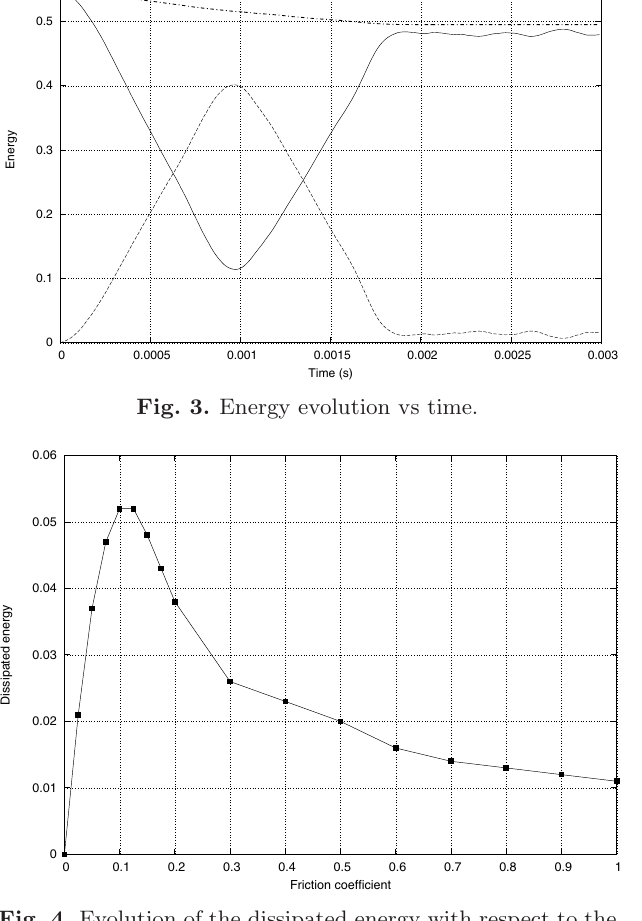
Fig. 4. Evolution of the dissipated energy with respect to the friction coefficient.